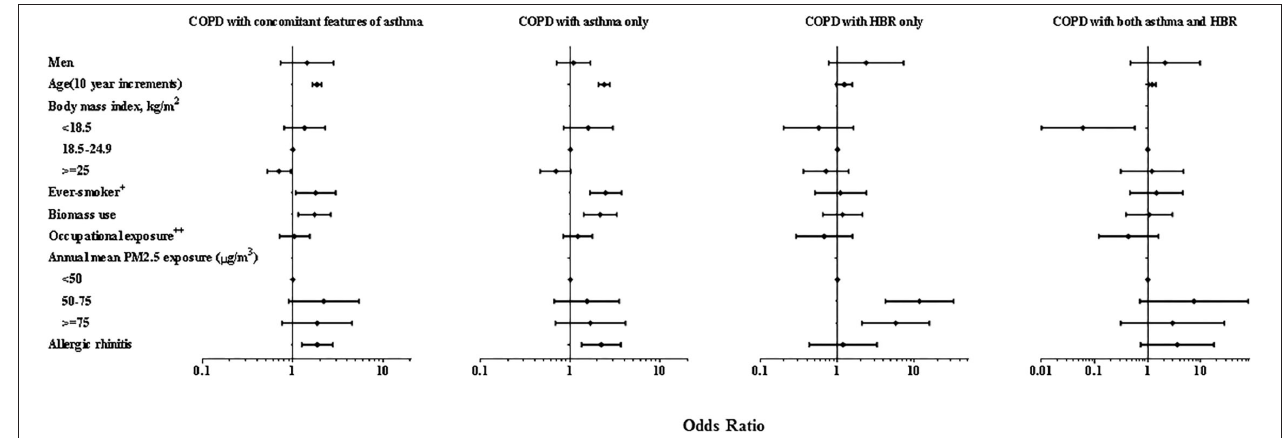
FIGURE 2 | Forest plot of multiple adjusted odds ratios for COPD with concomitant features of asthma. Multivariable-adjusted analyses included all co-variable listed in the figure. ORs are represented by black blot while the 95% CI is presented by horizontal bars. 1.00 indicates reference values. HBR, highly bronchodilator responsiveness. PM2.5, ambient particulate matter with a diameter < 2.5 µ m. + Ever smoker was defined as having smoked equal to or > 100 cigarettes in his/her lifetime. ++ Occupational exposure was defined as exposed to gas, smoke, chemical vapors or fumes in work above 3 months in his/her